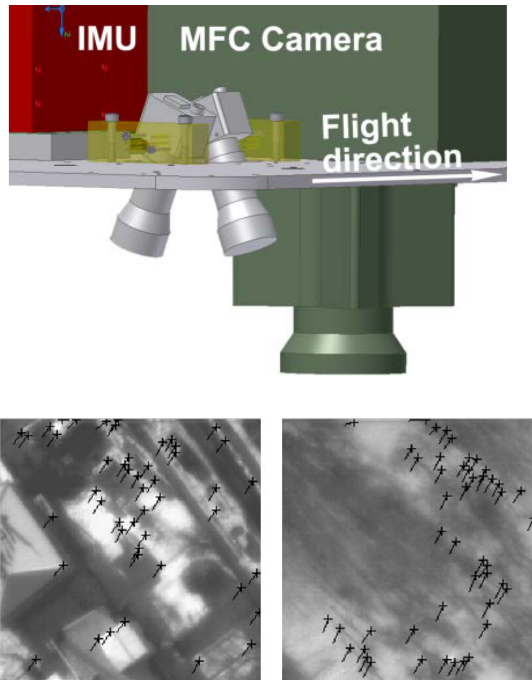
Figure 3: Upper: Test flight configuration with the MFC line camera and two auxiliary high-speed cameras mounted on the ground plate. Lower: Selected and tracked features from the auxiliary sensors. The trail of the features indicates their shift vectors relative to their position in the previous image